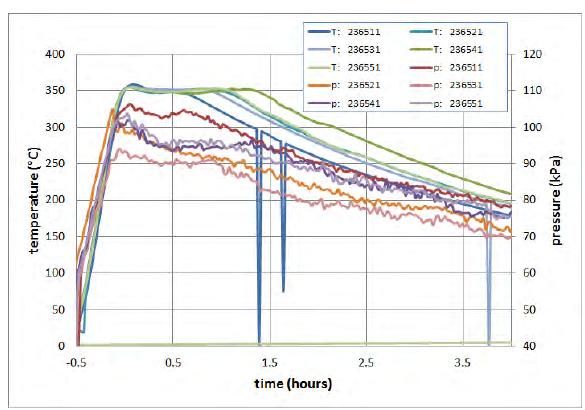
Figure 3. Temperature and pressure during hydrida- tion process.